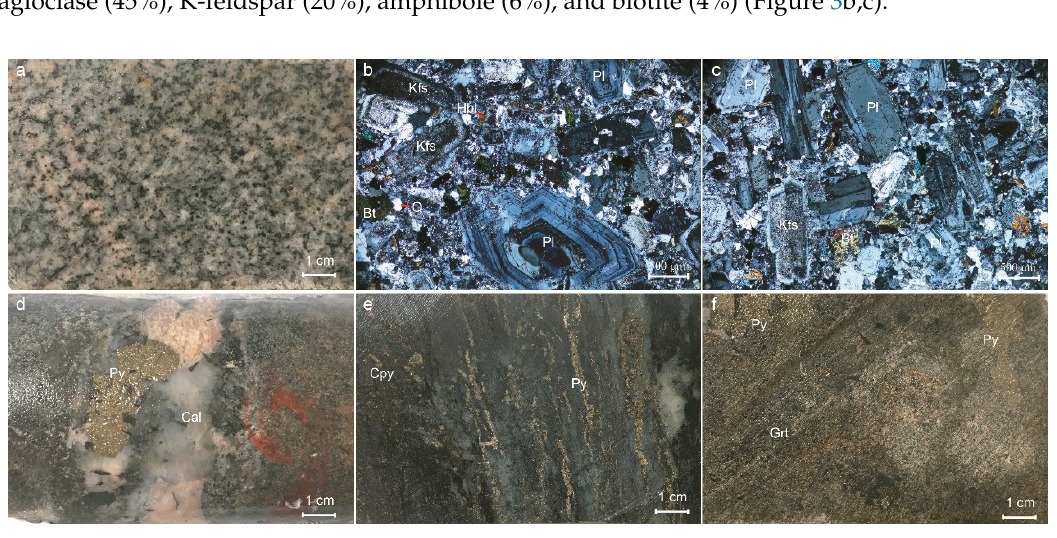
Figure 3. Hand specimens and photomicrographs of rock and mineralogy in the Hucunnan Cu–Mo deposit. ( a ) Granodiorite hand specimen; ( b , c ) granodiorite photomicrograph; ( d ) granular pyrite; ( e ) vein pyrite; ( f ) pyrite in skarn. Py, pyrite; Cpy, chalcopyrite; Kfs, K-feldspar; Bt, biotite; Q, quartz; Pl, plagioclase; Hbl, hornblende; Grt, garnet; Cal, calcite. Table 2. Minerals generated sequence table of the Hucunnan Cu–Mo deposit. Mineral Skarn Stage Oxide Stage Quartz-sulfide Stage Quartz-carbonate Stage Garnet